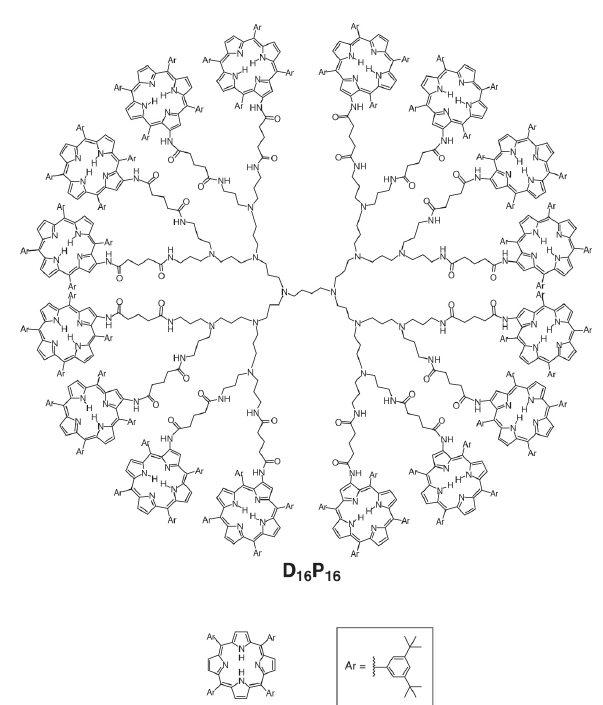
Figure 1. Prophyrin Dendrimer D n P n .